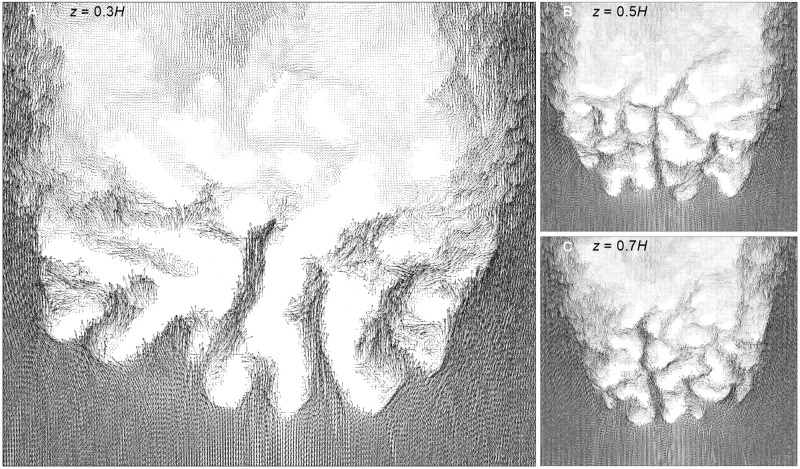
Top view of velocity vector fields at three heights inside the P. meandrina colony.The vector fields were obtained at heights z = 0.3H (left), 0.5H (top right), and 0.7H (bottom right) above the base of the coral colony, where H is the colony height. The figures show higher velocity magnitudes at the anterior end of the colony and allow one to gauge how far the oncoming flow can penetrate easily into the colony before it is slowed substantially by frictive contact with the coral branches.